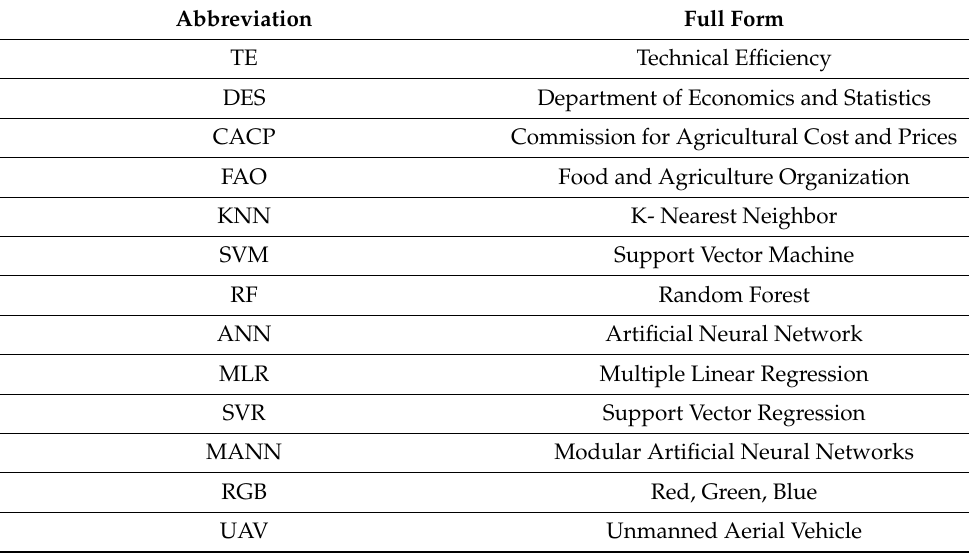
Table A3. Abbreviations for institutions, machine learning models and other technical